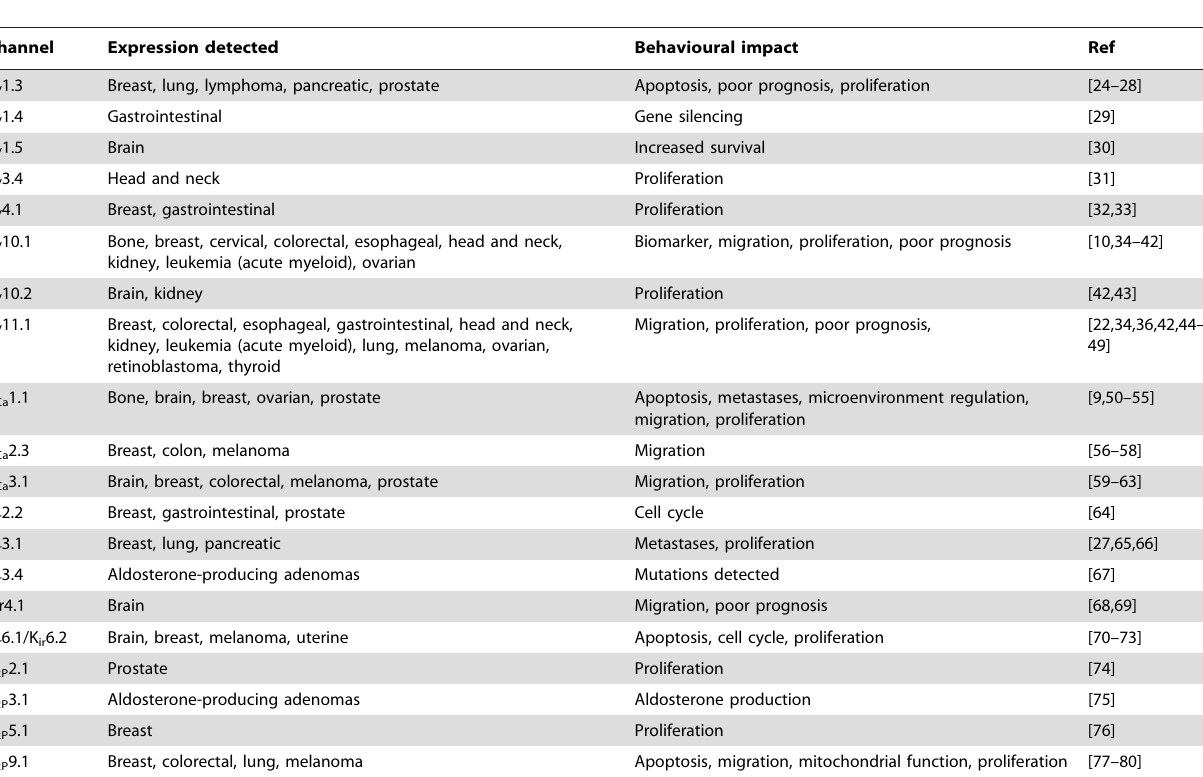
Table 1. Summary of potassium channel expression in